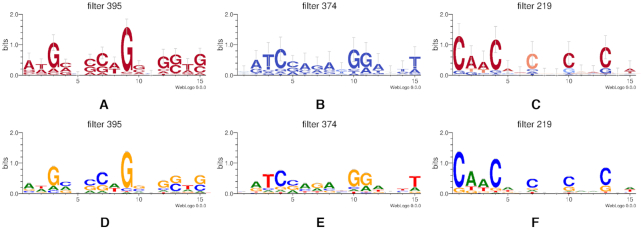
Nucleotide contribution logos of example filters. (A) Second-highest mean contribution score (CNNAll). Error bars correspond to Bayesian 95% confidence intervals. (B) Lowest mean contribution score (CNNAll). (C) Gaps resembling a codon structure, extracted from Bartoszewicz et al. (24). Consensus sequence: CAWCNNCNNCNNCNN. (D–F) Analogous logos created with the DeepBind-like ‘max-activation’ approach. Our ‘max-contrib’ logos visualize contributions of individual nucleotides, including counter-contributions.